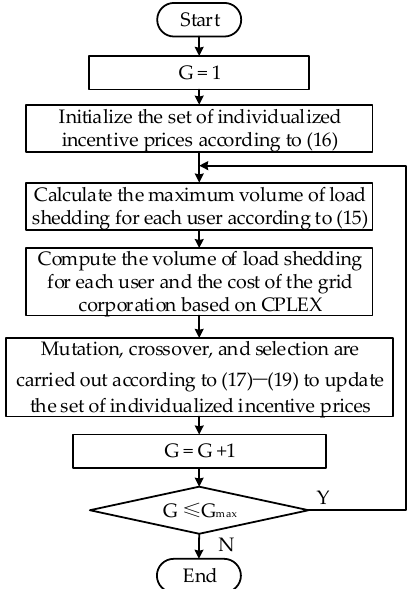
Figure 3. Flowchart of the Stackelberg game for solving the equilibrium solutions.